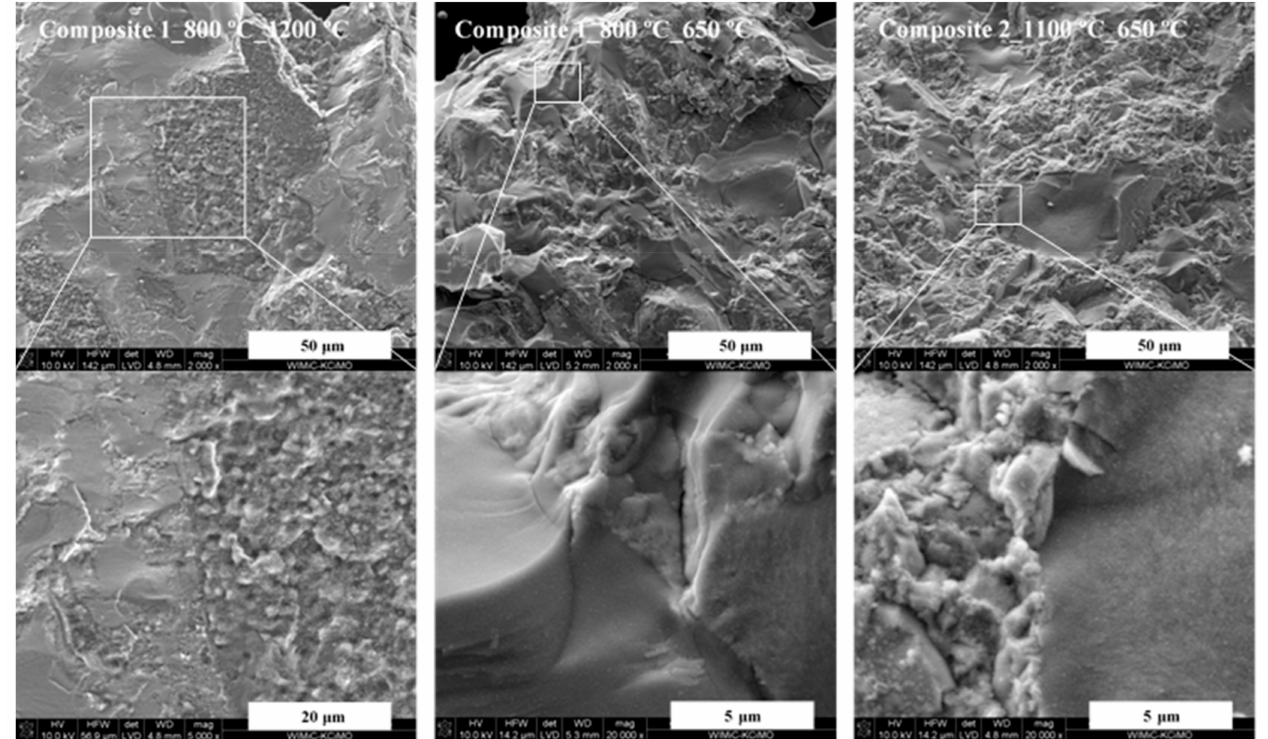
Figure 6. Typical SEM images of fractured composite nanoceramics: ( left )—Composite 1 made from Precursor 1 nitrided at 800 ◦ C then sintered at 1200 ◦ C; ( middle )—Composite 1 made from Precursor 1 nitrided at 800 ◦ C then sintered at 650 ◦ C; ( right )—Composite 2 made from Precursor 2 nitrided at 1100 ◦ C then sintered at 650 ◦ C. Note that areas in white-edge rectangles are magnified and shown in adjoining